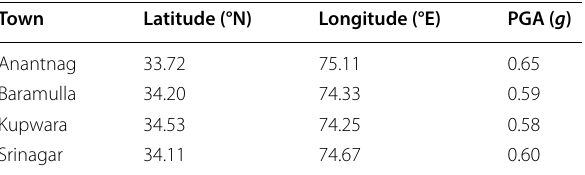
Table 3 Predicted peak ground acceleration (PGA) in g of major towns in Kashmir basin with 10% probability of exceedance in 50 years